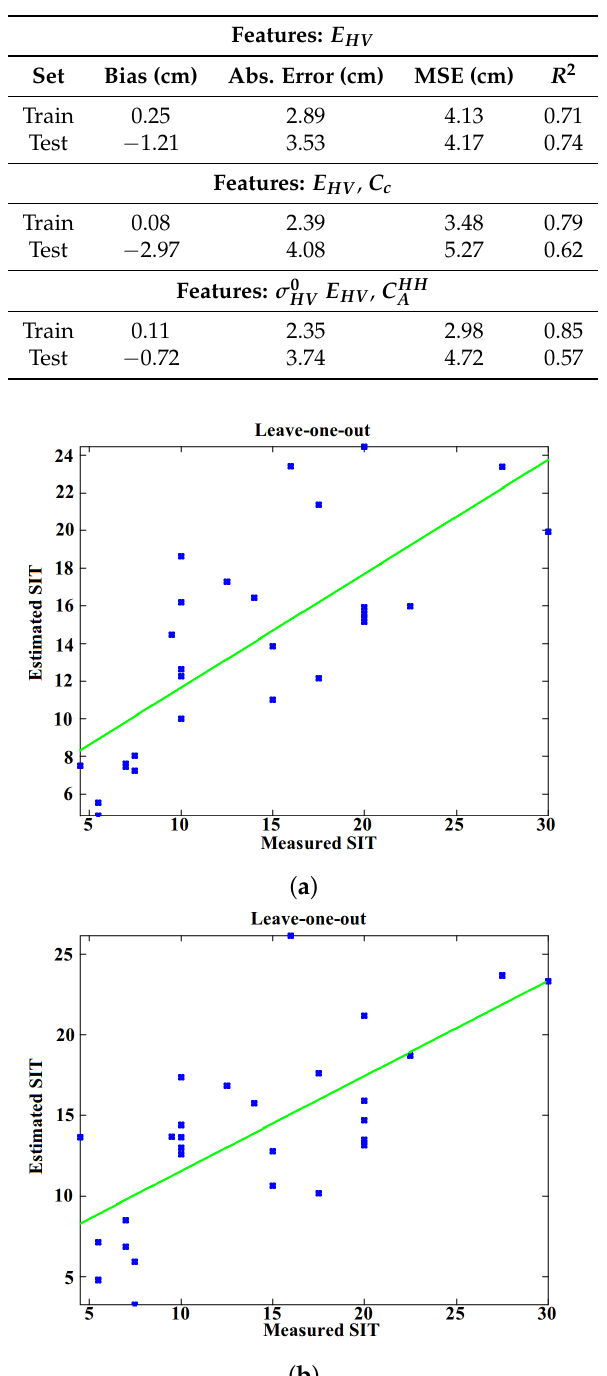
Table 4. Sea ice thickness estimation errors.